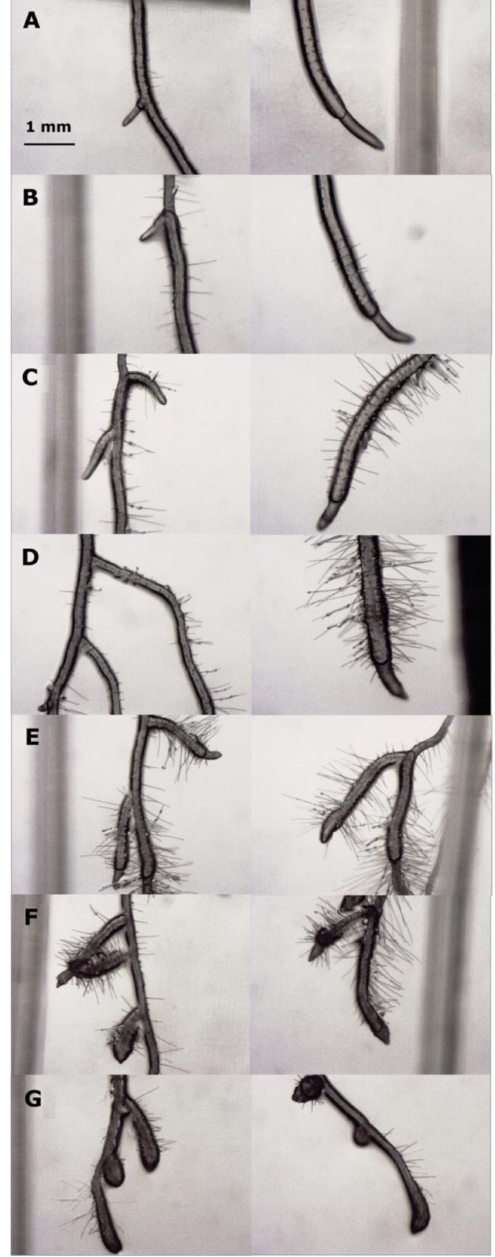
Figure 2. Stereoscopic microscopy images of Arabidopsis roots exposed to increasing doses of pro- todioscin: ( A ) control (0 µ M); ( B ) 15.6 µ M; ( C ) 31.3 µ M; ( D ) 62.5 µ M; ( E ) 125 µ M; ( F ) 250 µ M and ( G ) 500 µ M. Scale bar 1